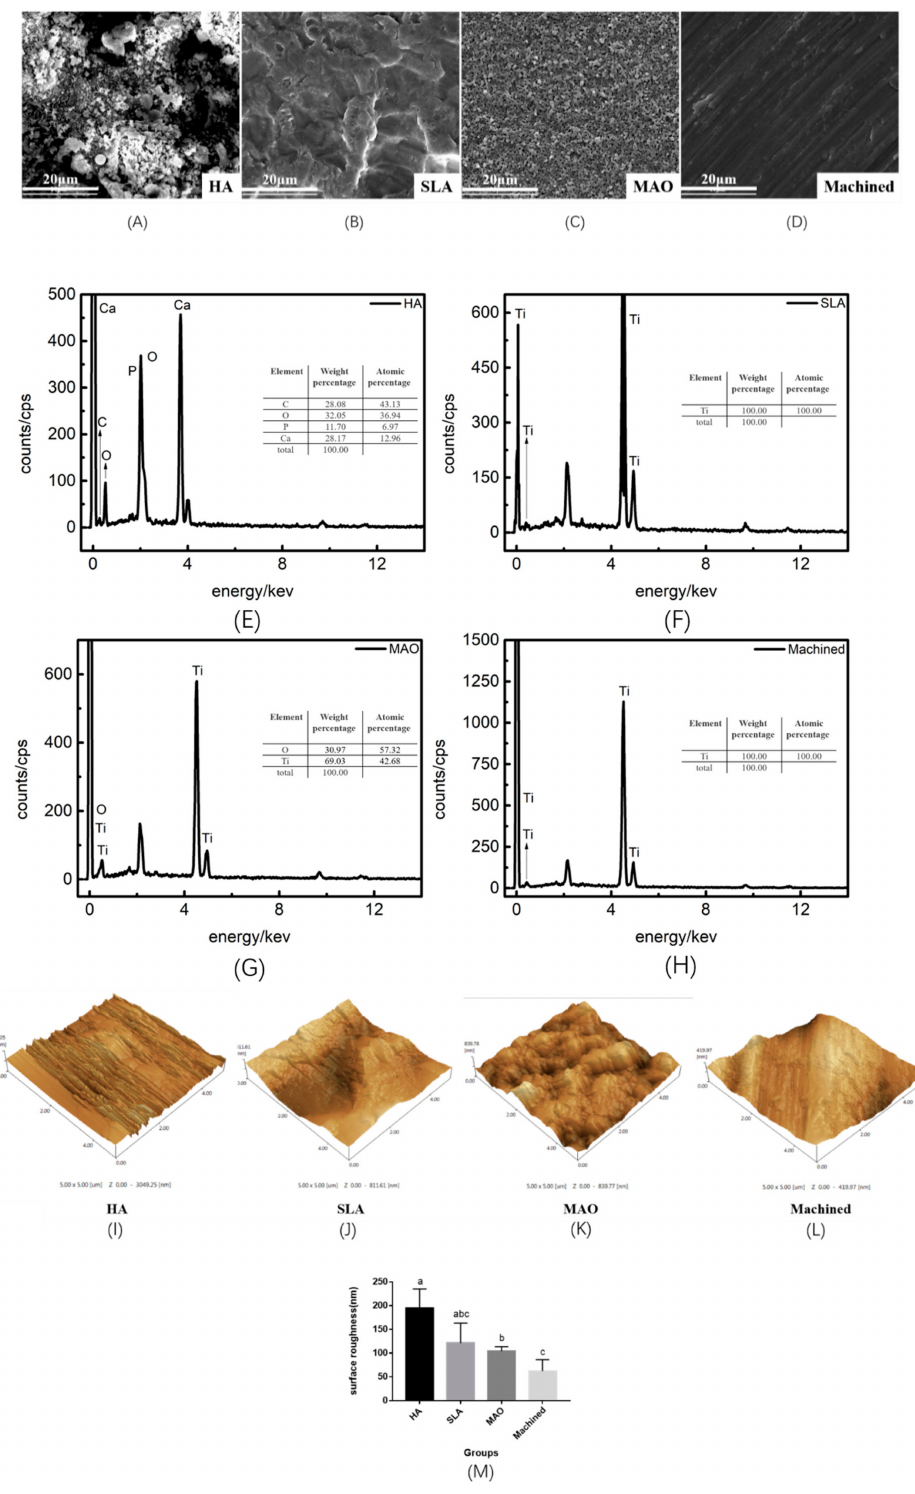
Figure 1. The surface structures of four types of titanium discs (plasma hydroxyapatite spraying (HA), sandblasting and acid etching (SLA), micro-arc oxidation (MAO), and machined) were observed by scanning electron microscopy (SEM), atomic force microscope (AFM) and energy dispersive X-Ray spectroscopy (EDX). ( A , E , I ) HA: plasma-sprayed hydroxyapatite; ( B , F , J ) SLA: sandblasting and acid etching; ( C , G , K ) MAO: micro-arc oxidation; ( D , H , L ) machined; and ( M ) the surface roughness of titanium. Significant di ff erences between the bars are marked with di ff erent letters (a, b, and c) ( p <